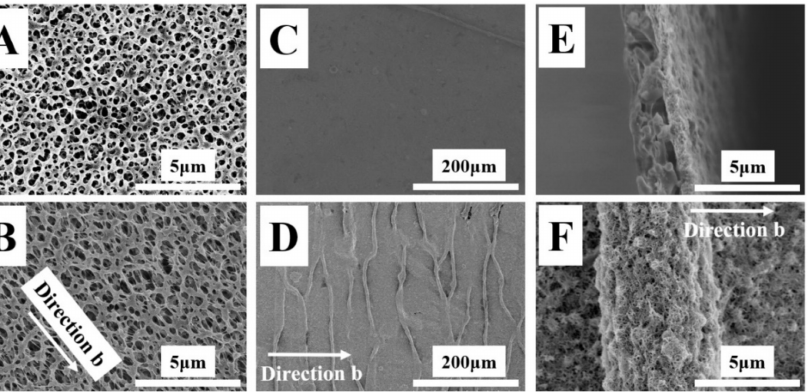
Figure 1. SEM images of porous PLLA membranes ( A ), deformed membranes ( B ), CNTs loaded on PLLA membranes ( C ) and membranes with wrinkles after recovery of PLLA ( D ). ( F ) shows one wrinkle with higher magnification and ( E ) illustrates the cross-section of the composite membrane of